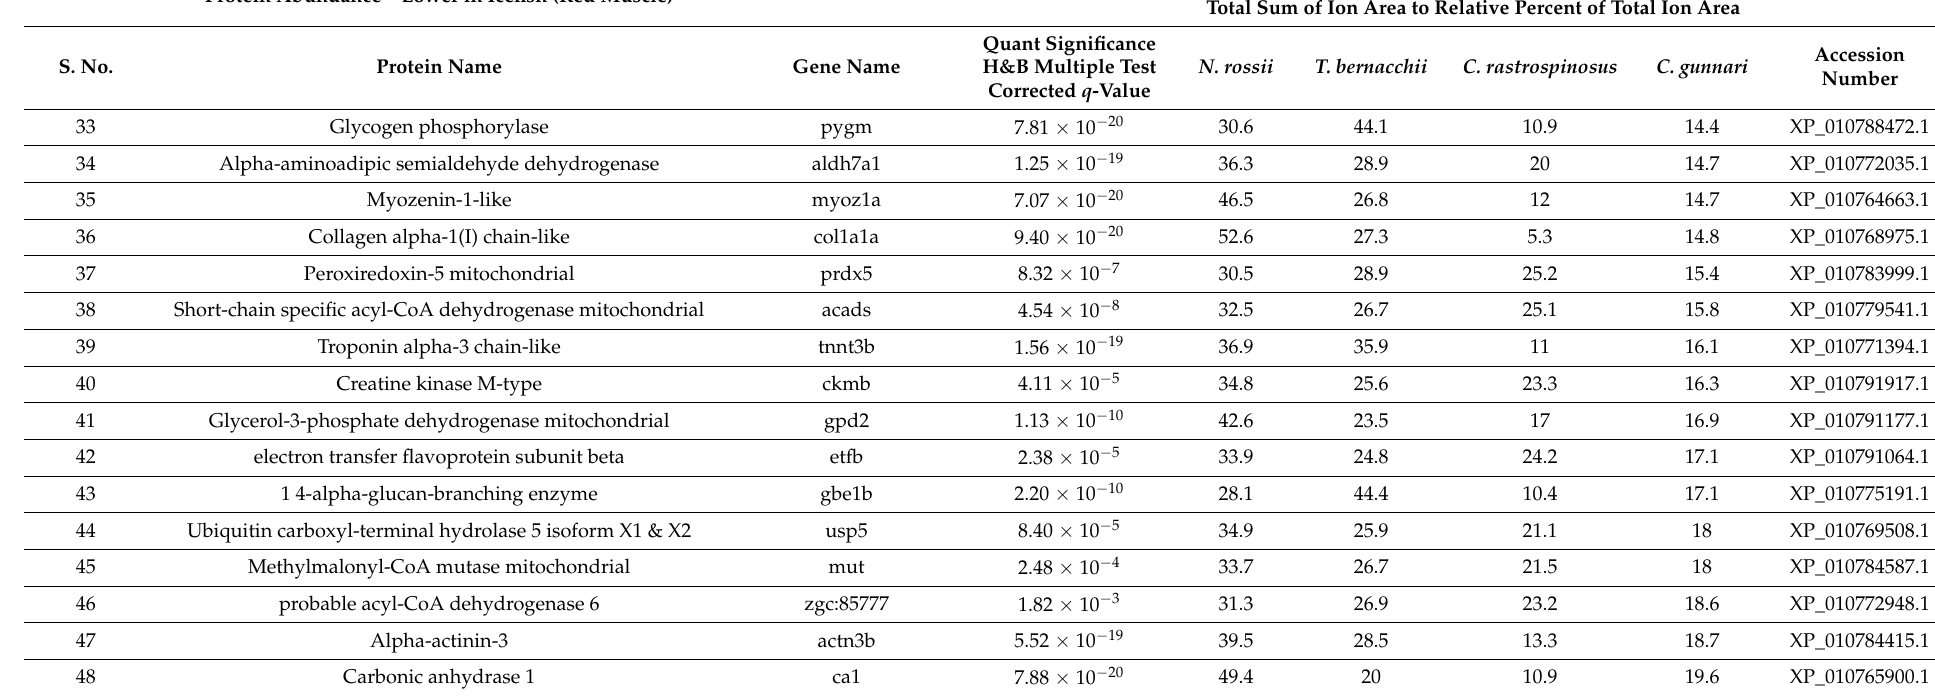
Protein Abundance—Lower in Icefish (Red